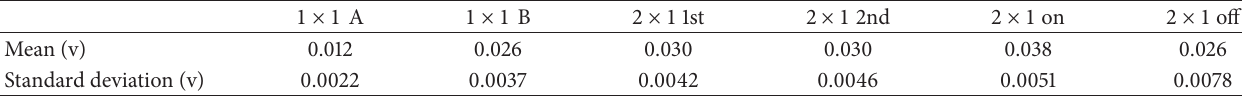
Table 1: Mean and standard deviation of measured average magnitude.